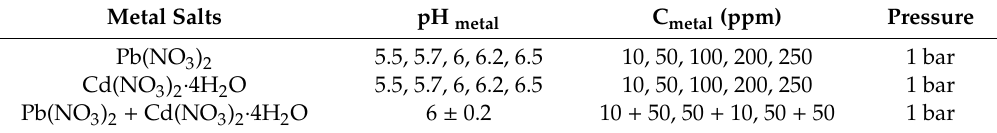
Figure 1. A schematic diagram of the membrane filtration test system. Table 2. Operating conditions of the hollow fiber membrane separation process.